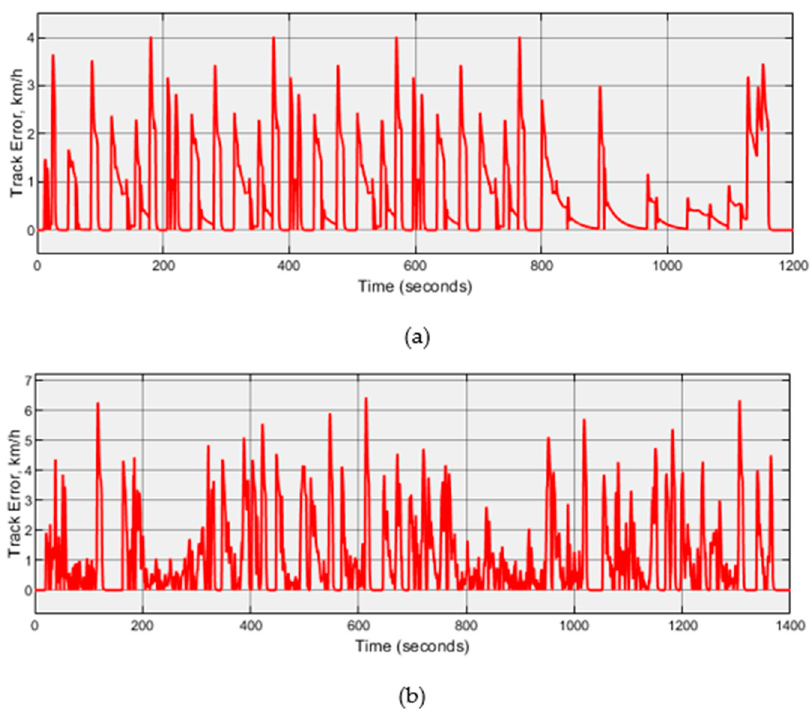
Figure 10. Vehicle tracking error for EV with a two-speed transmission system on: ( a ) NEDC and ( b ) UDDS drive cycles. Table 7. Optimization of gear ratios and gearshift schedule in relation to vehicle acceleration of a two- speed transmission system in the EV model on the NEDC and UDDS drive cycles.